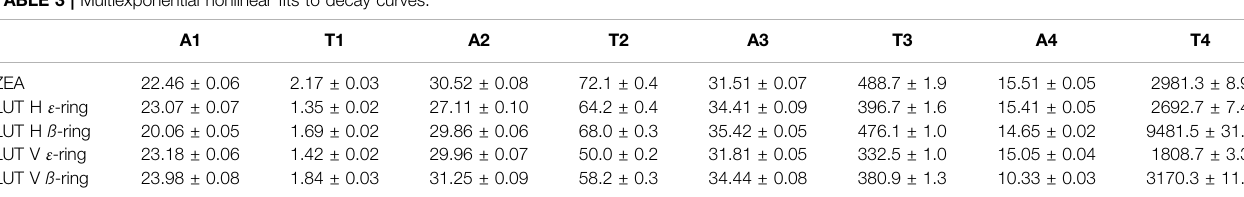
Relative contributions ( Ai , %) and time constants ( T i , ps) of decay curve components for the zeaxanthin ß -ring; horizontallutein ε -ring and ß -ring; vertical lutein ε -ring and ß -ring, H-bonds with water in the PC-ZEA_V, PC-LUT_H, PC-LUT_V, bilayers, respectively. The decay curves were fi tted to a sum of four exponentials. Errors in the fi tted parameters correspond to standard